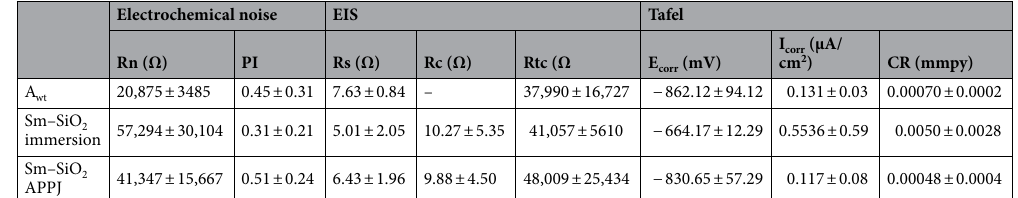
Electrochemical noise